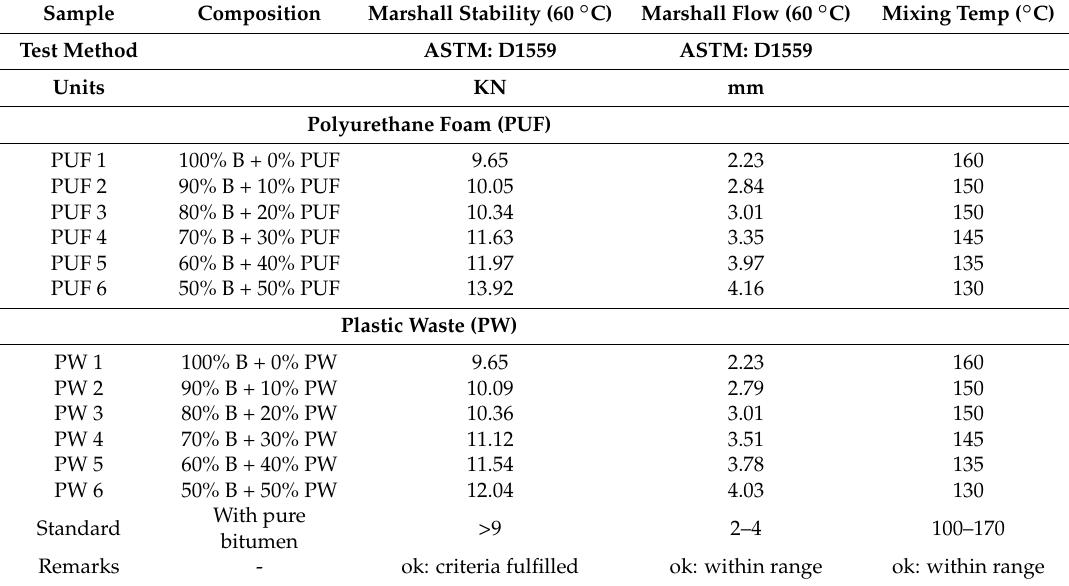
Table 5. Stability and flow analysis of asphalt mix samples with modified and unmodified